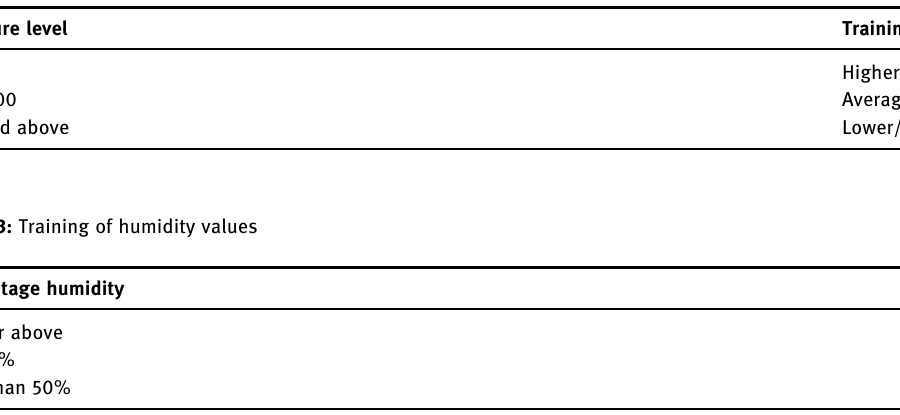
Table 2: Training of moisture values